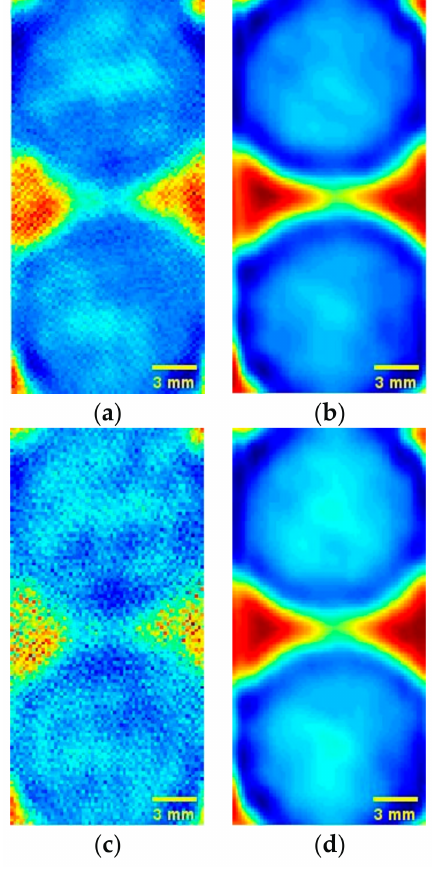
Figure 5. Reconstructed results comparation of DSC-THz and SSC-THz with different sampling rates for the circular solids. ( a ) DSC-THz with sampling rate 10%; ( b ) DSC-THz with sampling rate 30%; ( c ) SSC-THz with sampling rate 10%; ( d ) SSC-THz with sampling rate 30%.